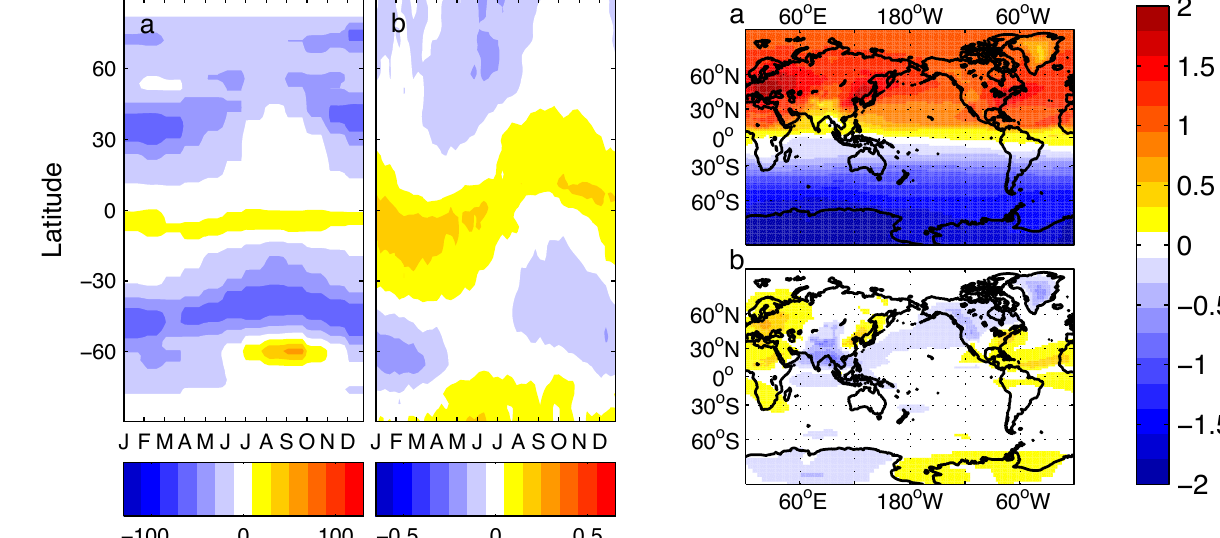
Fig. 3. (a) August h CO 2 i fossil with global mean removed. Be- cause the bulk of emissions occurs in the north, mean h CO 2 i fossil is 2ppm higher in the Northern Hemisphere than in the Southern Hemisphere. (b) Deviation of August h CO 2 i fossil from the zonal mean at each latitude. Contrasts in h CO 2 i fossil between emission regions (e.g., eastern United States, Europe, and China) and upwind regions are less than 1ppm. Overall, the meridional gradients are stronger than the zonal